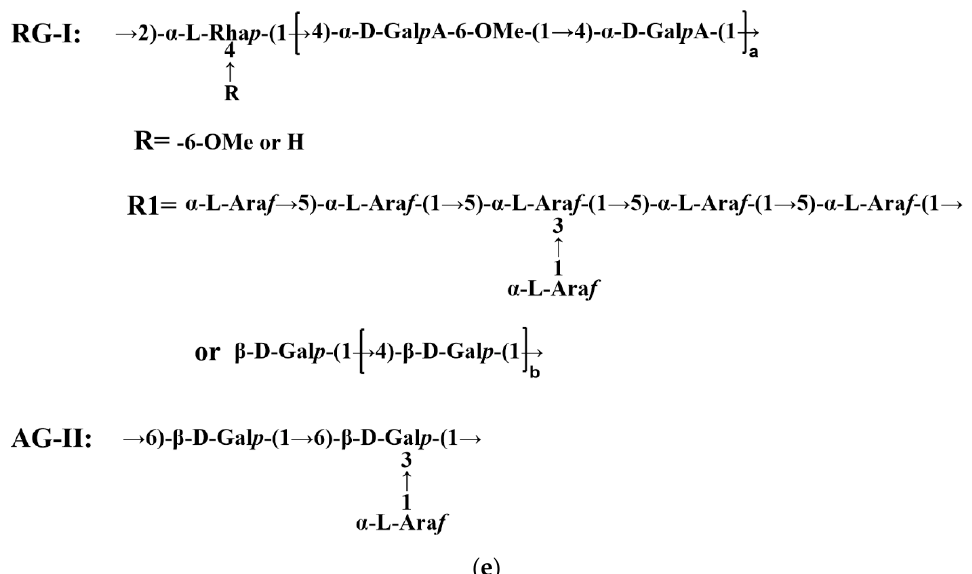
Figure 3. 1 H ( a ), 13 C ( b ), HSQC ( c ), HMBC ( d ) spectra of DLP120 and structural model ( e ) of DLP120.